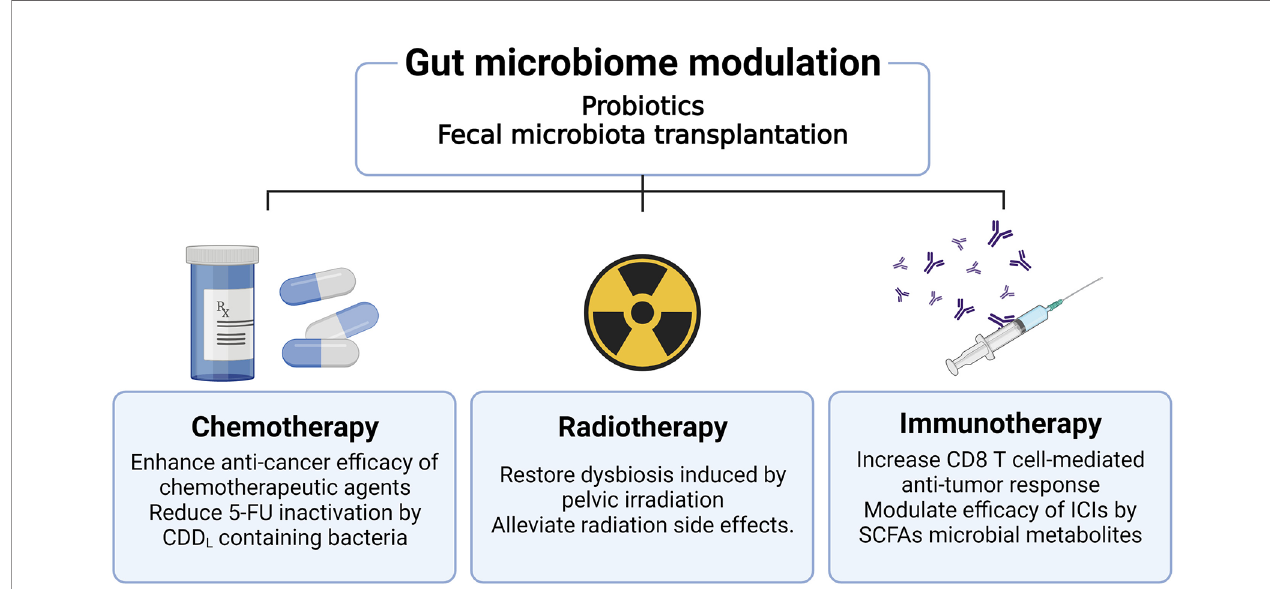
FIGURE 2 | Effects of gut microbiome modulation on cancer treatment. Therapies which modulate the gut microbiome, including administration of probiotics or fecal microbiota transplantation, improve the ef fi cacy of cancer treatment. Administration of antibiotics can reduce the ef fi cacy of oxaliplatin and CpG oligodeoxynucleotides chemotherapeutic agents. The use of antibiotics increases pathogenic bacteria such as Escherichia shigella and Enterobacter , as well as reduces the anti-cancer effect of 5-FU. Radiation of the pelvic area causes dysbiosis and has the potential to affect the treatment modality of CRC. Furthermore, radiation-induced gut epithelial damage worsens the prognosis of CRC patients. These radiation side effects can be ameliorated through fecal microbiome transplantation as well as probiotics administration. The gut microbiota plays a role in modulating mucosal immunity in the colorectal region, acting to improve the ef fi cacy of immunotherapy by enhancing the CD8+ T cell immune response or SCFA metabolite